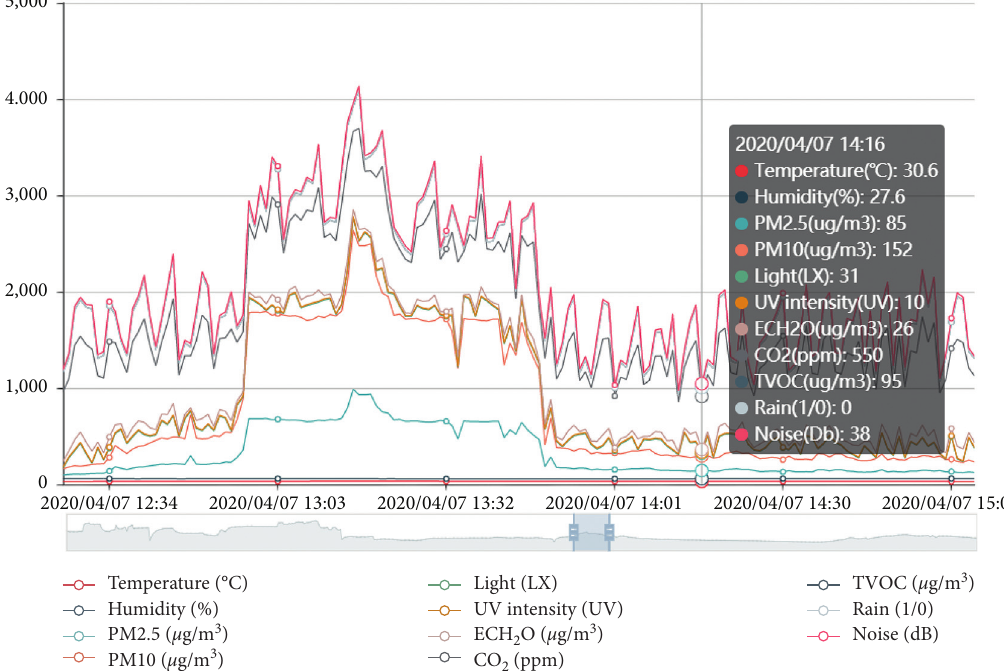
Figure 8: Comprehensive diagram of real-time data of eleven kinds of